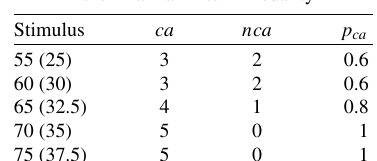
Fig.17. Psychometricfunctionestimatedonthetestwiththeperfect stiffness experiments. The ∗ are the experimental data, the line is the fitted Weibull distribution.